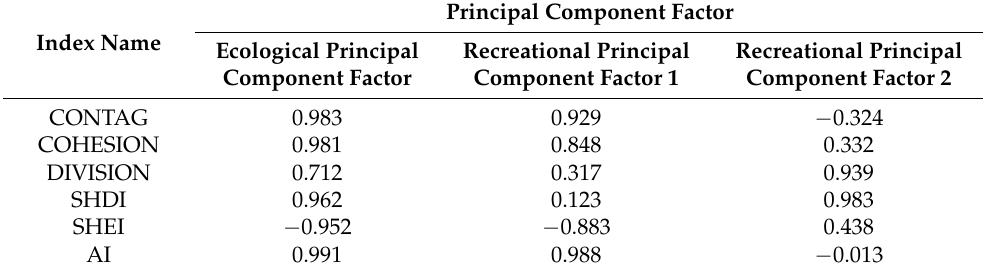
Table 2. Principal component